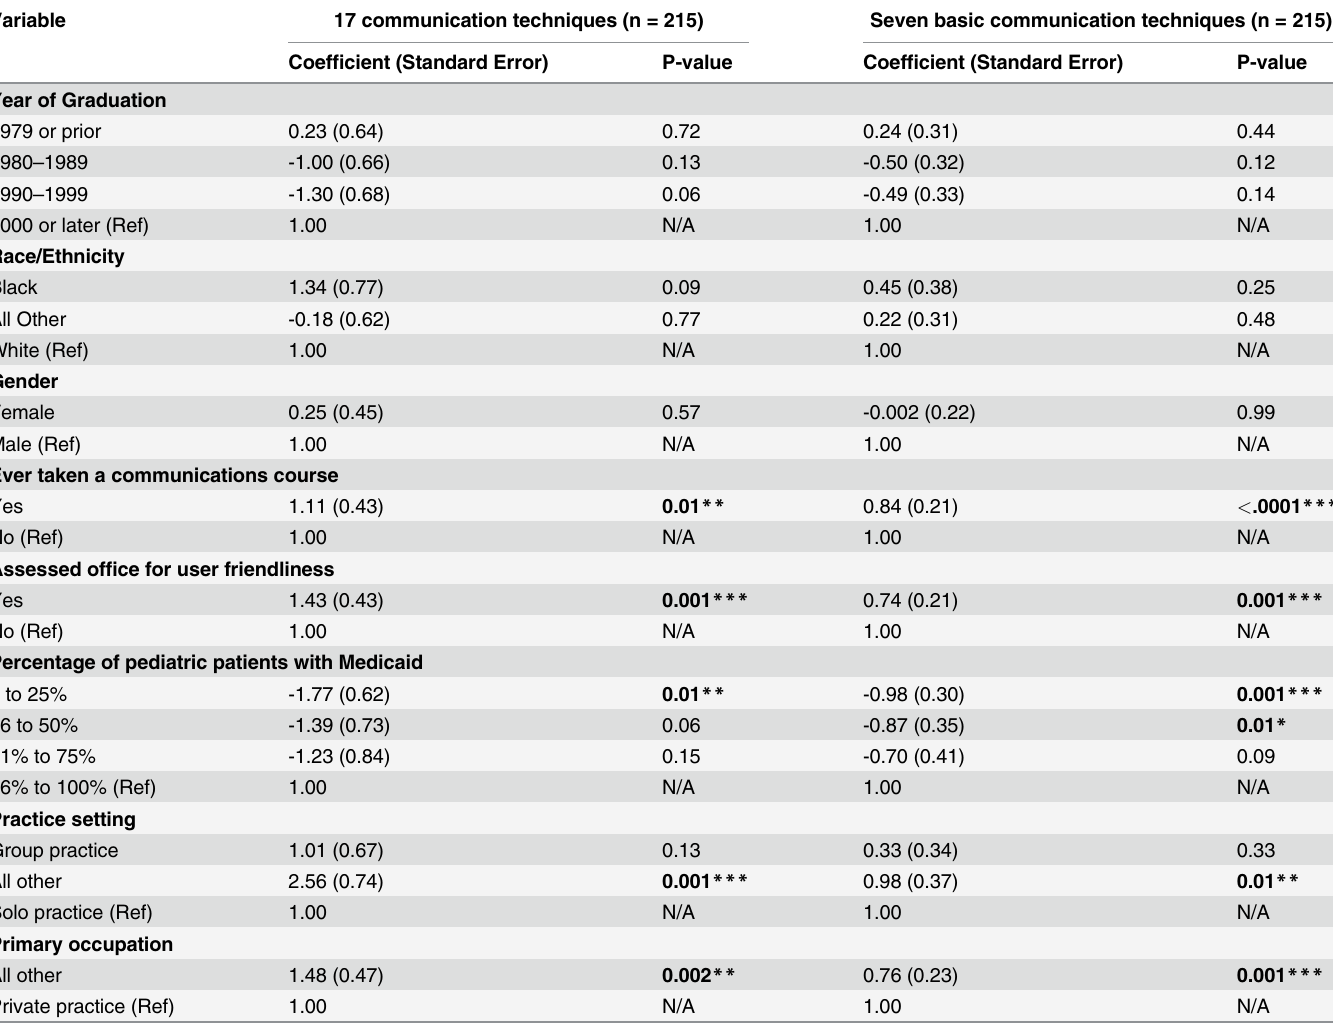
Table 8. Ordinary least squares regression of predictor variables on number of communication techniques used by